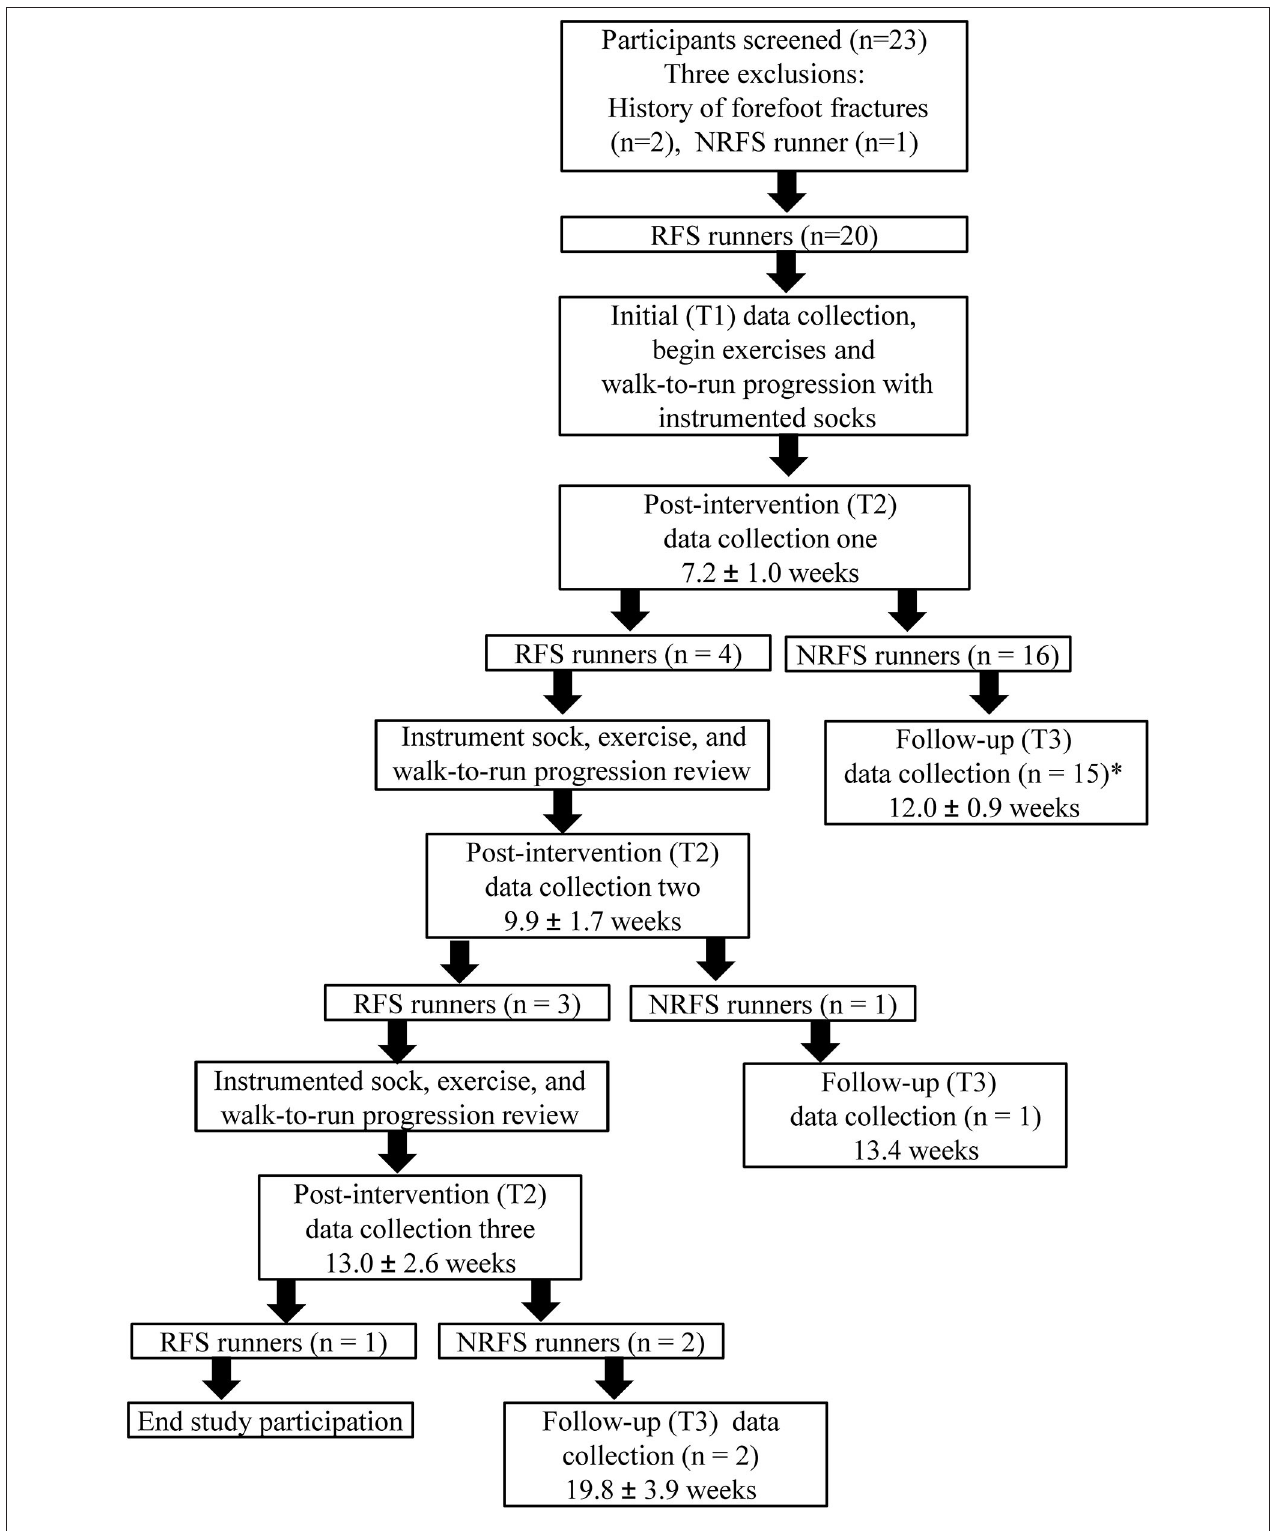
FIGURE 1 | Participant flowchart and study methodology. RFS, rearfoot strike; NRFS, non-rearfoot strike. Values are reported as mean and standard deviation from the day 0 point of the study. *One participant was diagnosed with mononucleosis prior to the follow-up data collection. To prevent bias with an intention to treat analysis, all data from this participant were excluded from statistical analysis. Post-intervention (T2) data collection at 6, 8, and/or 10 weeks (post-intervention data collection one, two, and three respectively) following the initial data collection. If the participant achieved a NRFS at post-intervention (T2), they were asked to return for a follow-up 4 weeks later